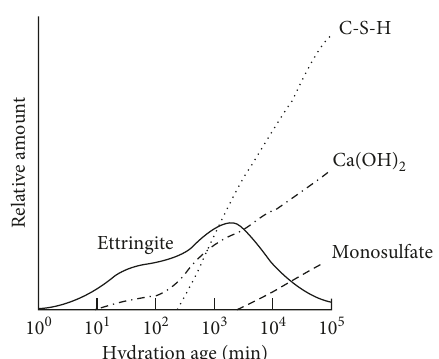
Figure 16: Relative amount of different hydration products during hydration